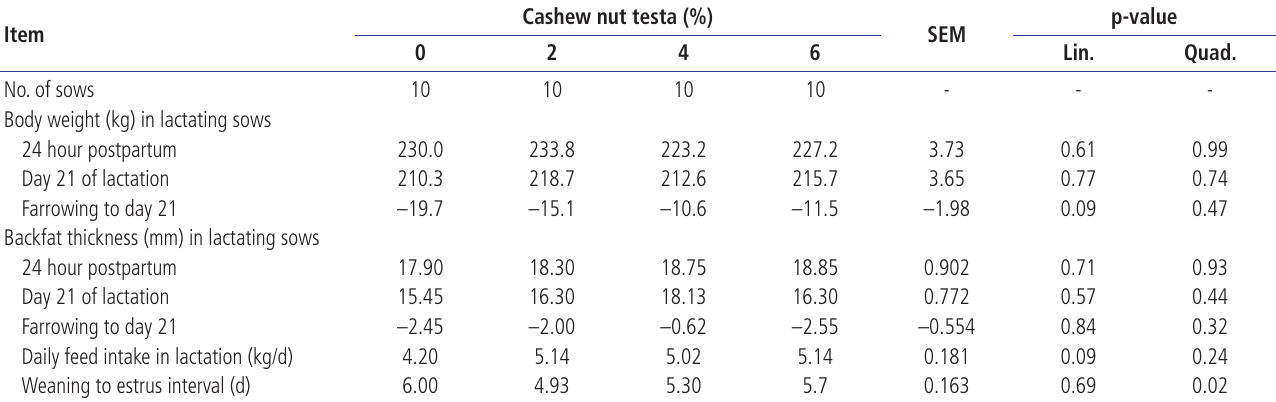
Table 5. Effects of cashew nut testa level on body weight, back-fat thickness, weaning to estrus interval and daily feed intake in lactating sows